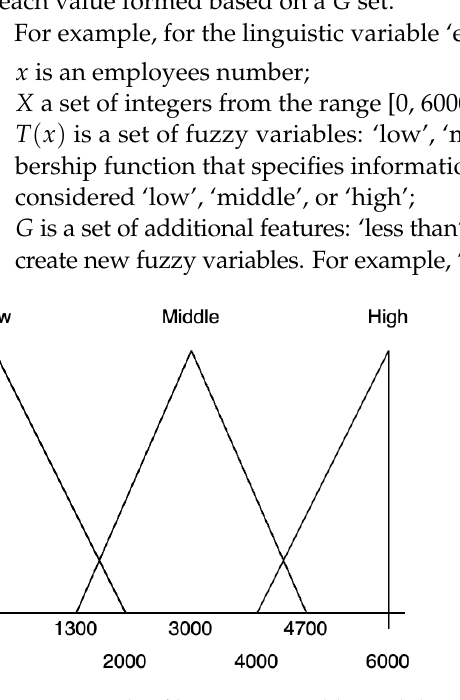
Figure 3. Example of linguistic variables and their membership